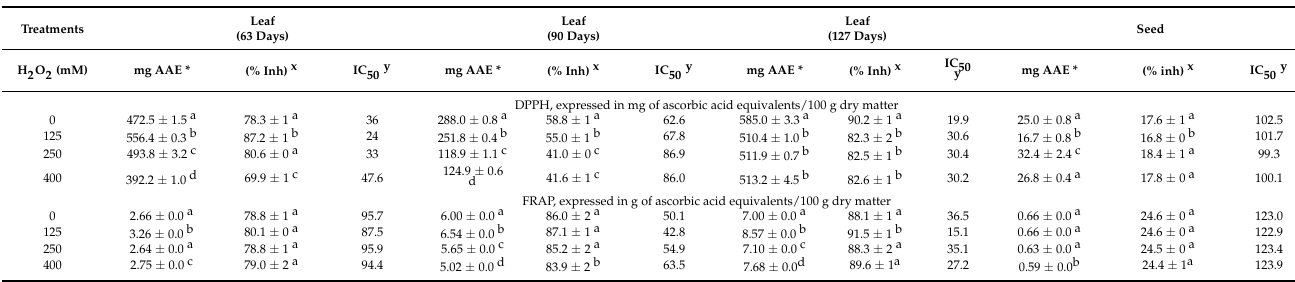
Table 3. Results of the antioxidant capacity by DPPH and FRAP methods in amaranth leaf and seed ( Amaranthus hypochondriacus